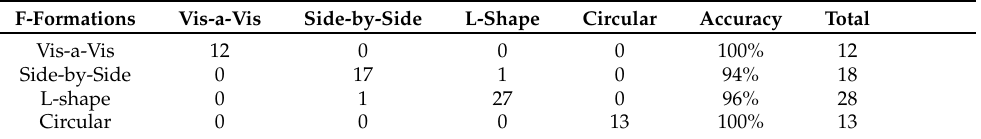
Table 9. Estimating F-formations in Scene 2: confusion matrix and accuracy.